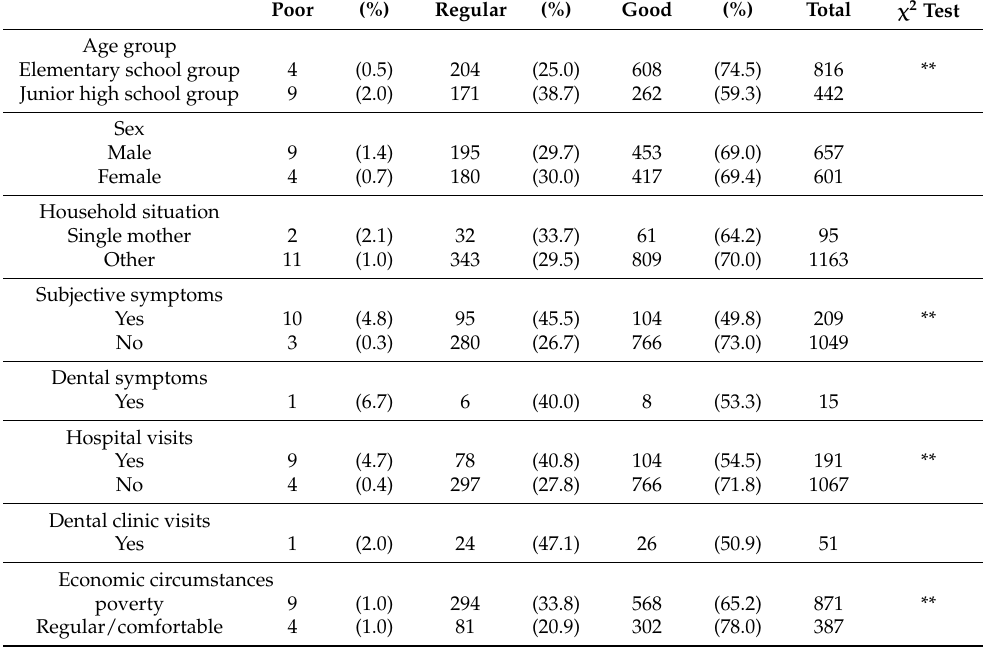
Table 5. Perceived health status by response